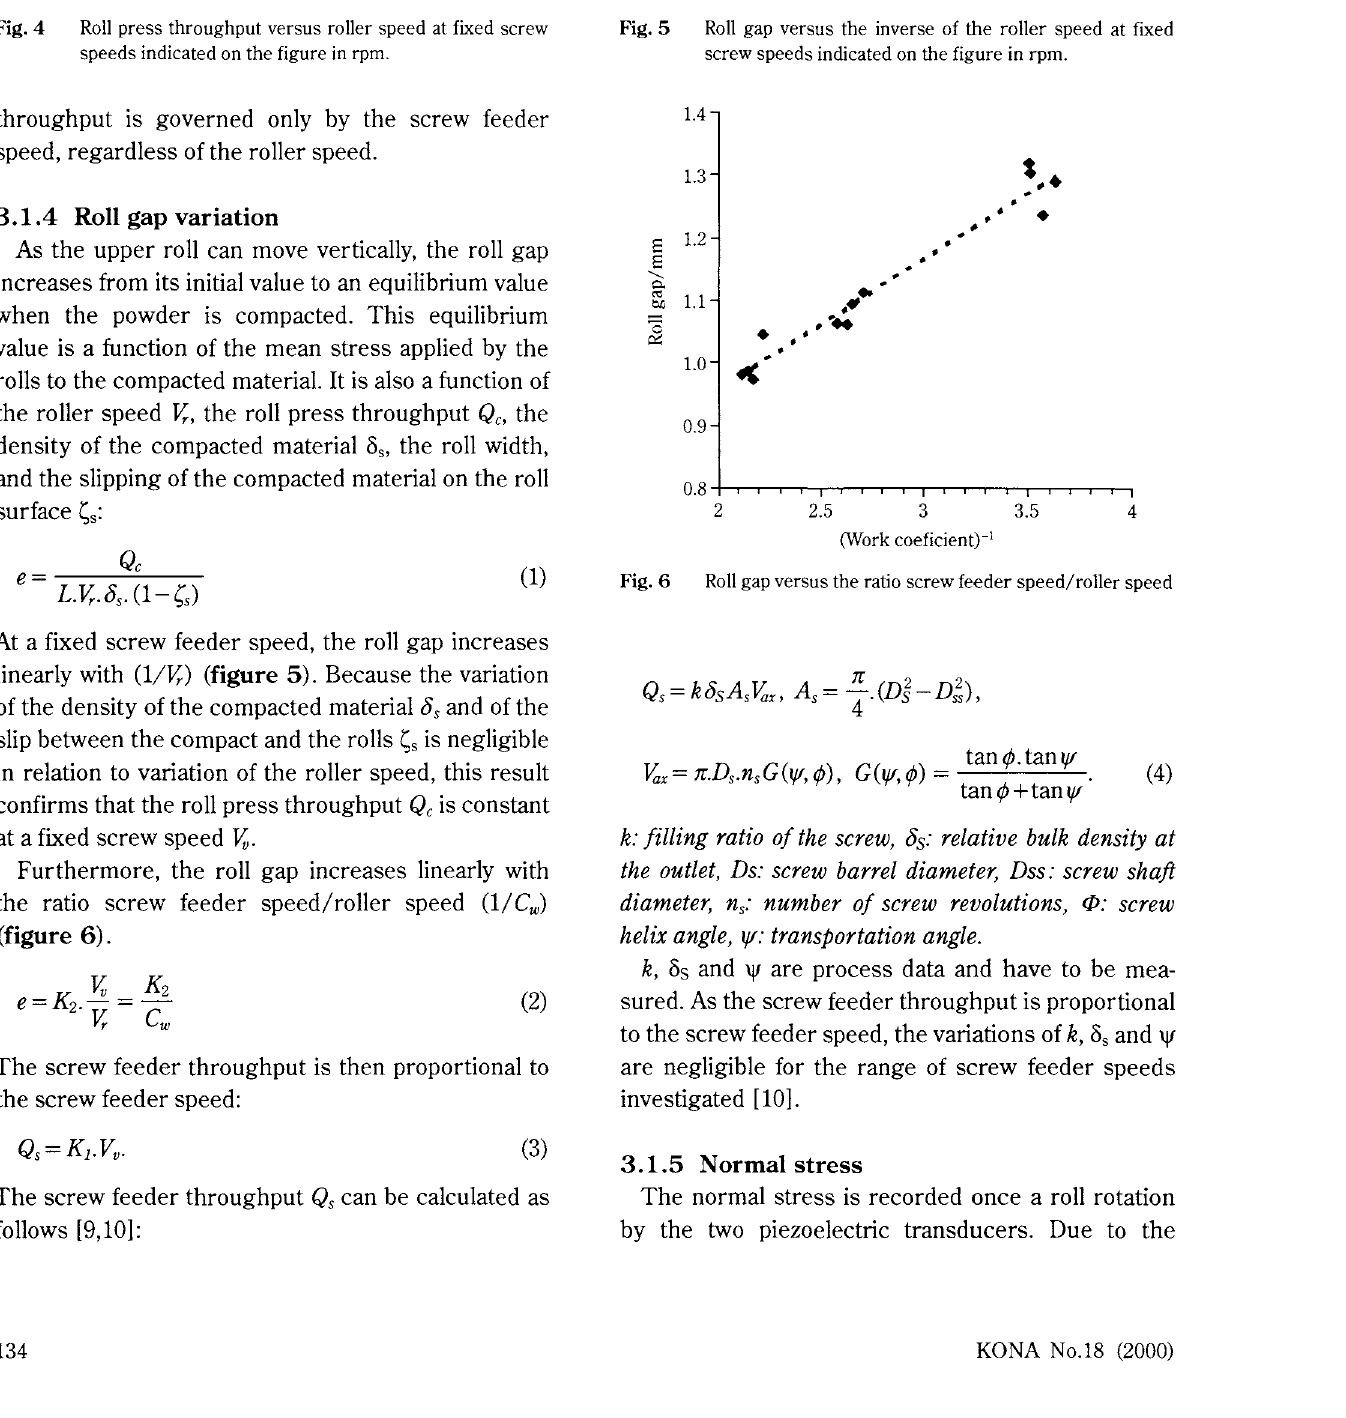
Roll gap versus the inverse of the roller speed at fixed screw speeds indicated on the figure in rpm. 1.4 1.3